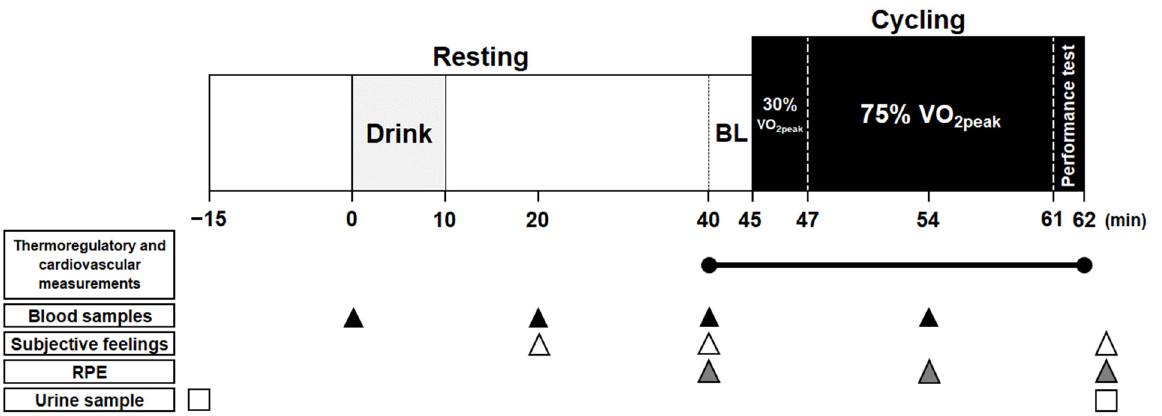
Figure 1. Schematic timeline of experimental protocol. RPE, rate of perceived exertion; BL, baseline.